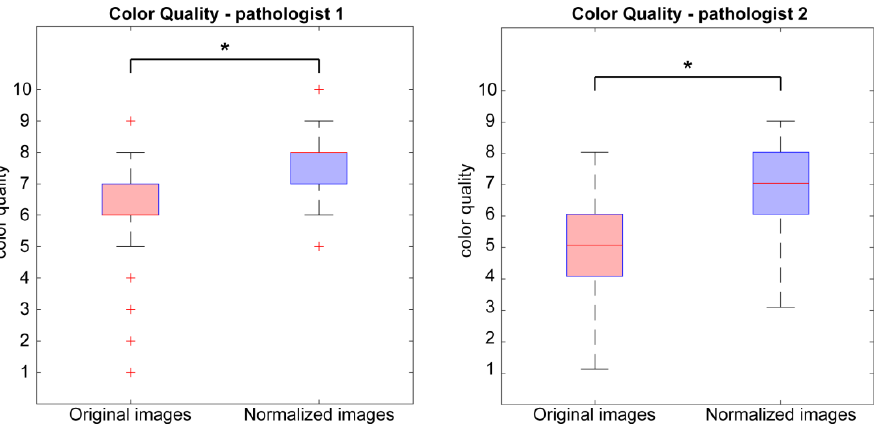
Figure 4. Boxplots of distributions of color quality values of original images (red) and normalized images (blue). The evaluation of the first pathologist (P1) is shown on the left, and the evaluation of the second pathologist (P2) is represented on the right. The plus symbol (+) indicates outliers in the distribution, while the asterisk (*) denotes a statistically significant difference between original and normalized images.